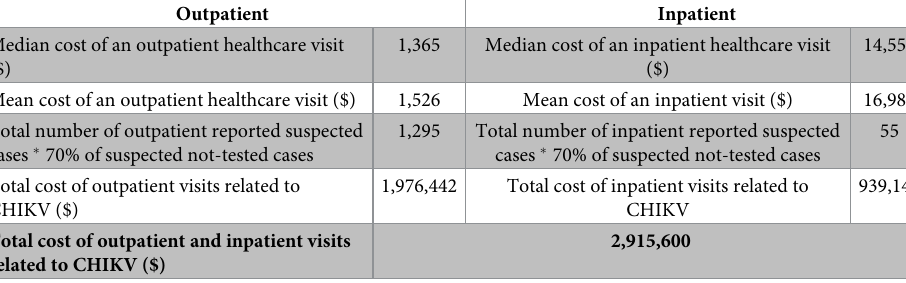
Table 3. Direct cost estimate (2014 USD) of the chikungunya outbreak in the U.S. Virgin Islands up to 2 months after illness onset, based on cost estimates from St. Croix. Outpatient Inpatient Median cost of an outpatient healthcare visit 1,365 Median cost of an inpatient healthcare visit 14,551 ($) ($) Mean cost of an outpatient healthcare visit ($) 1,526 Mean cost of an inpatient visit ($) 16,983 Total number of outpatient reported suspected 1,295 Total number of inpatient reported suspected 55 cases � 70% of suspected not-tested cases cases � 70% of suspected not-tested cases Total cost of outpatient visits related to 1,976,442 Total cost of inpatient visits related to 939,145 CHIKV ($) CHIKV Total cost of outpatient and inpatient visits 2,915,600 related to CHIKV ($) Note: Total cost estimate was rounded to the nearest